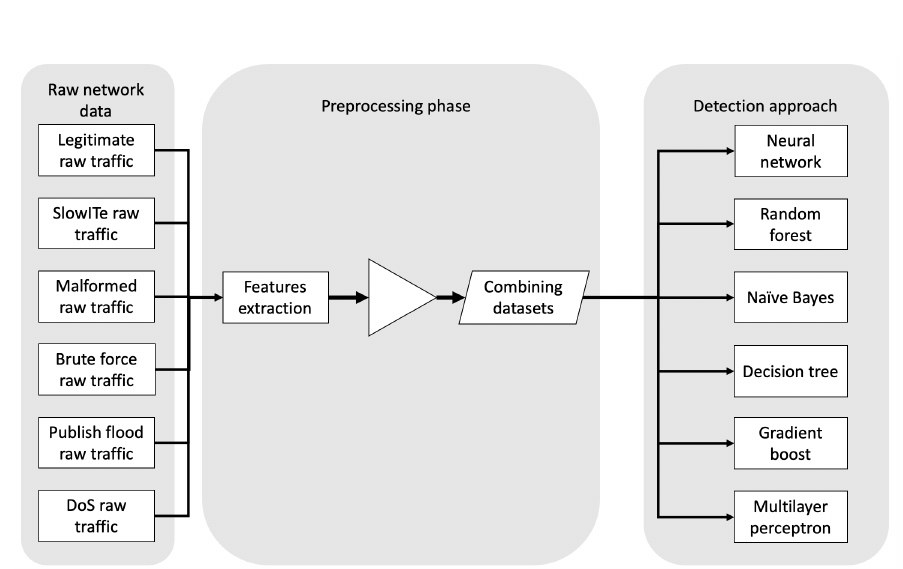
Figure 2. Considered workflow for MQTTset